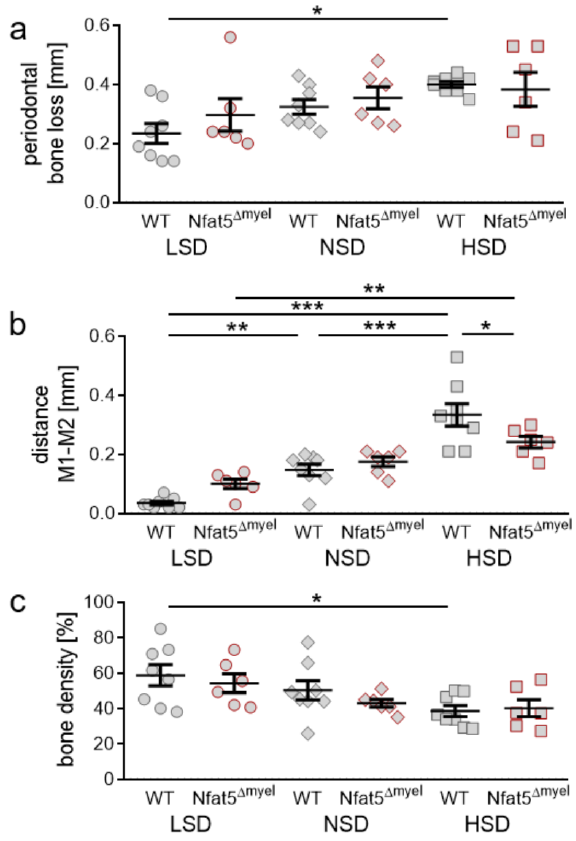
Figure 6. Analysis of periodontal bone loss ( a ), distance between the moved first (M1) and the second (M2) upper left molar ( b ) and bone density ( c ) after LSD, NSD or HSD in control or Nfat-5 Δmyel mice at the orthodontically treated side, based on µCT ( n ≥ 6). Symbols represent single data points, horizontal lines the arithmetic mean and vertical lines the standard error of the mean. AU: